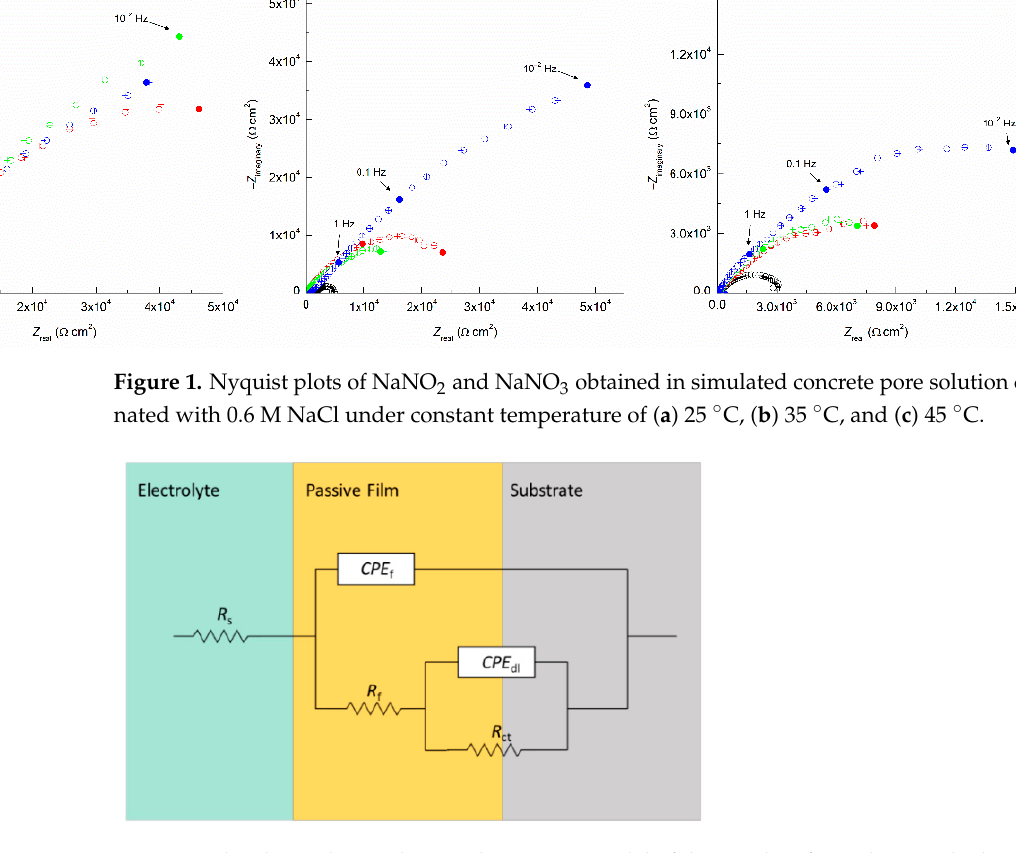
Figure 2. The electrochemical equivalent circuit model of the EIS data for carbon steel rebar in SCPS contaminated with 0.6 M Cl − in the presence of both NaNO 2 and NaNO 3 corrosion inhibitors.